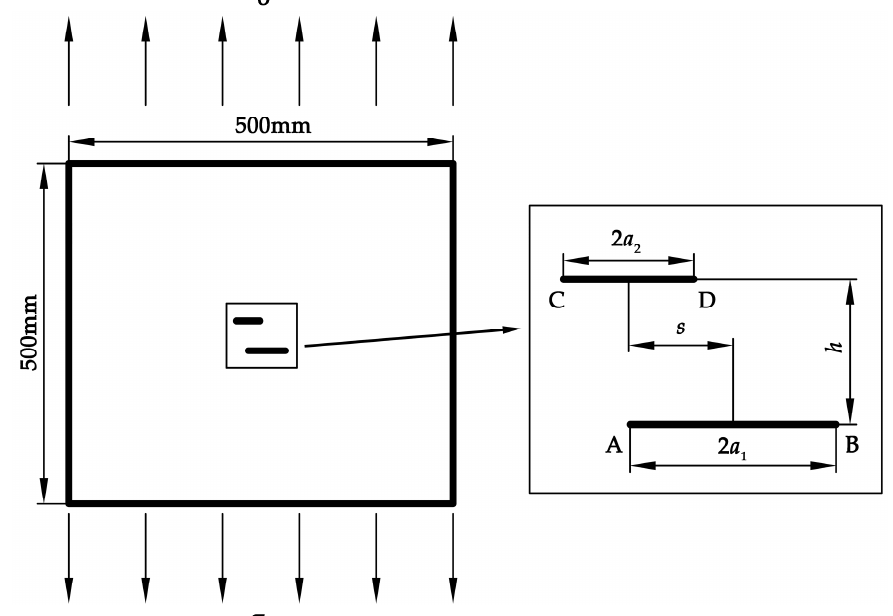
Figure 1. Geometric model of a plate with two parallel cracks.